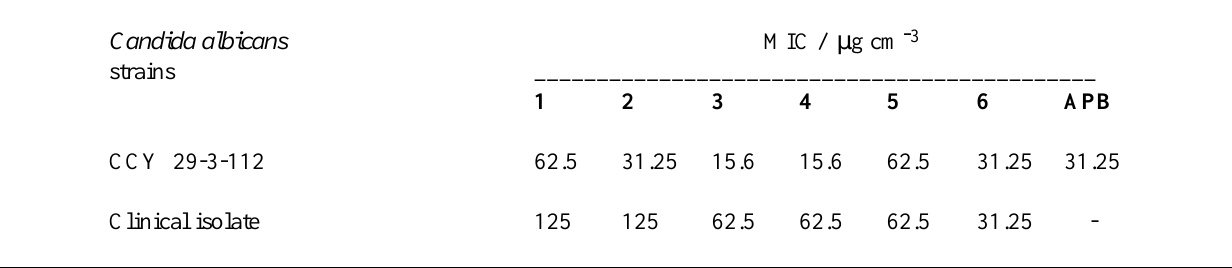
Table 3. Anticandidous activity of